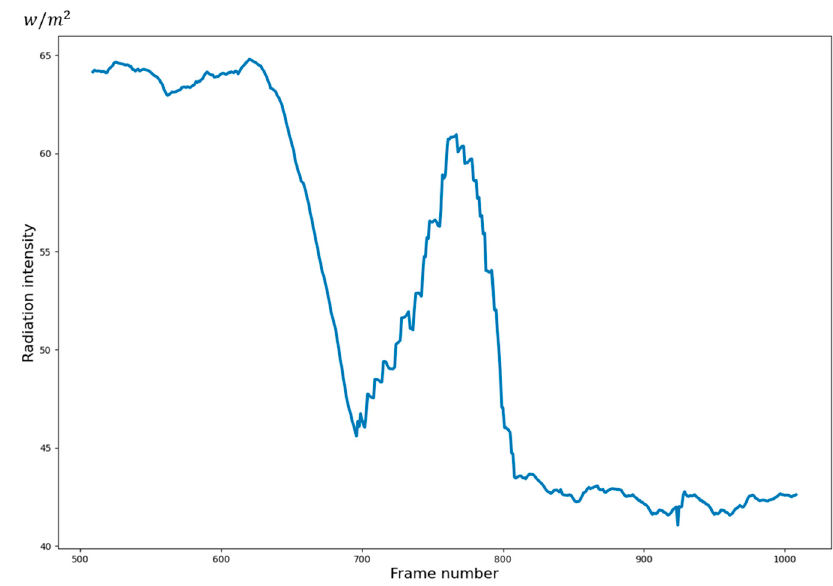
Figure 2. Target radiation characteristic variation curve.